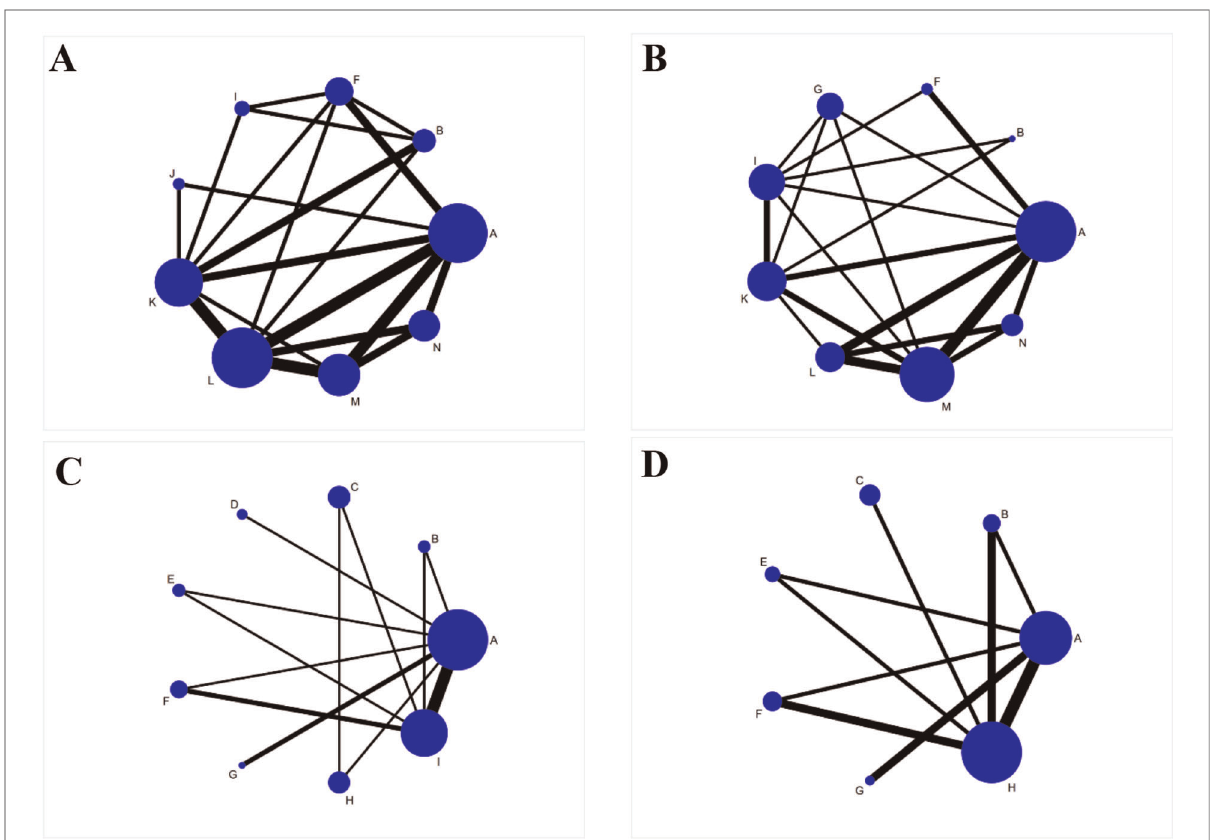
FIGURE 3 Reticulated evidence diagram of different rehabilitation intervention times after the operation. A: 1 day postoperatively, B: 2 days postoperatively, C: 1 week postoperatively, D: 8 days postoperatively, E: 10 days postoperatively, F: 2 weeks postoperatively, G: 3 weeks postoperatively, H: 4 weeks postoperatively, I: 6 weeks postoperatively, J: 9 weeks postoperatively, K: 12 weeks postoperatively, L: 6 months postoperatively, M: 12 months postoperatively, N: 24 months postoperatively. ( A ) Network evidence for AOFAS scores; ( B ) Network evidence for VAS scores; ( C ) Network evidence for total postoperative complication rates; ( D ) Network evidence for DVT